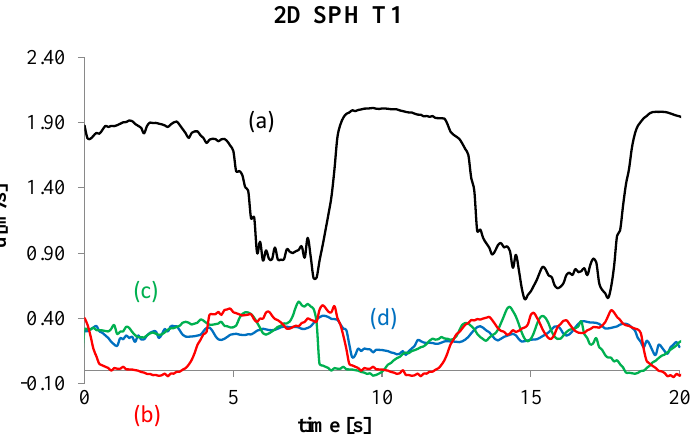
Figure 20. Time series of the horizontal velocity component under hydraulic jump (configuration: T1) measured at a distance of: ( a ) 7 cm; ( b ) 10 cm; ( c ) 20 cm; and ( d ) 100 cm, from the time-averaged position of the hydraulic jump toe.